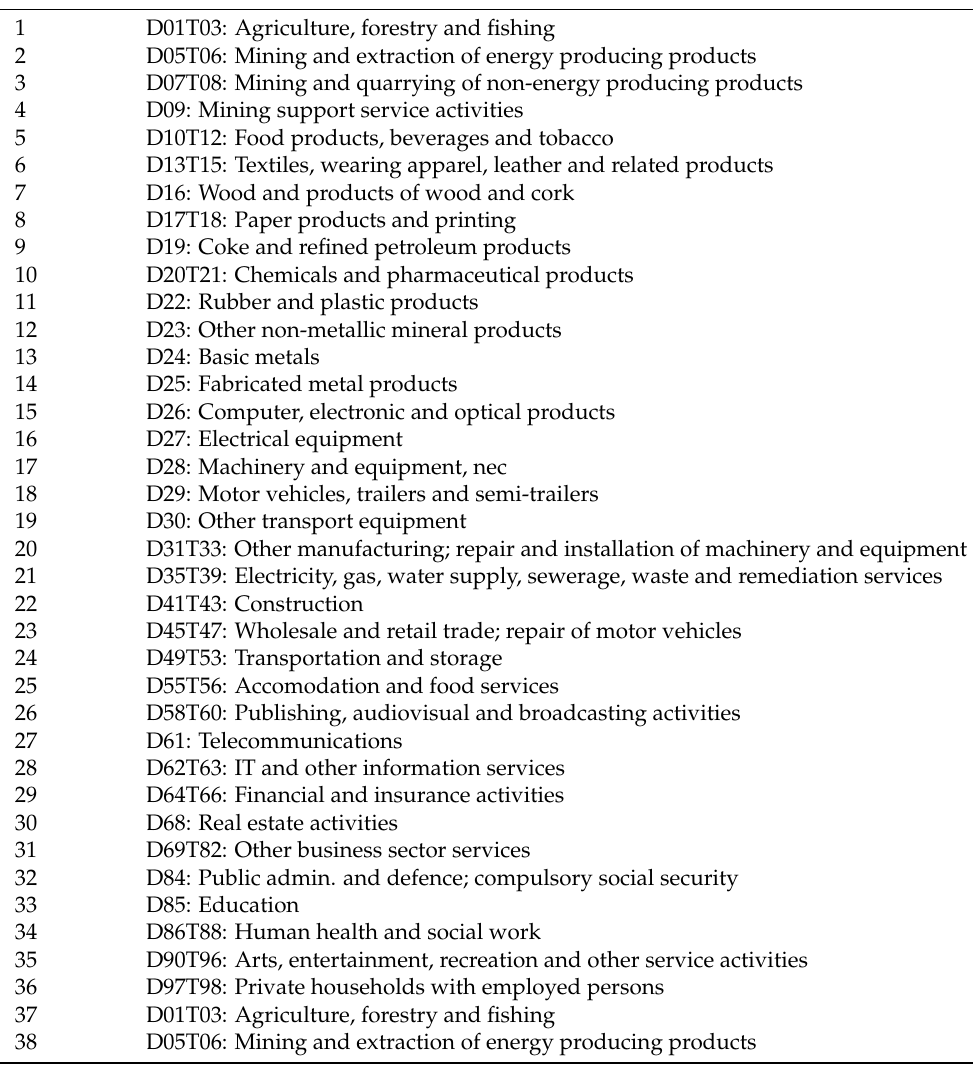
Table A2. Sector Classification of the 38 OECD economies.